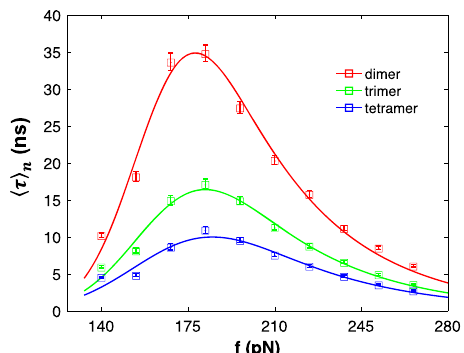
Fig. 6 Mean lifetime 〈 τ 〉 vs. force f curves for self-assembled fi bers at varying degrees of polymerization. Symbols are from MD simulations and the curves are generated with an exponentially modi fi ed Gaussian distribution fi tting function. The error bars represent 95% con fi dence intervals, derived by the bootstrapping